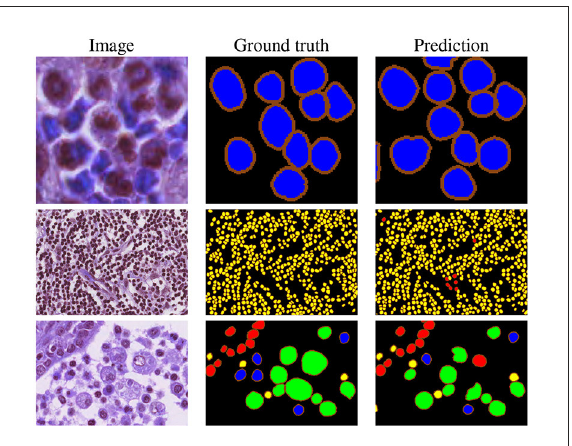
FIGURE7 Example results on MoNuSAC images. The colors in the ground truth and segmentation masks represent the different nuclei